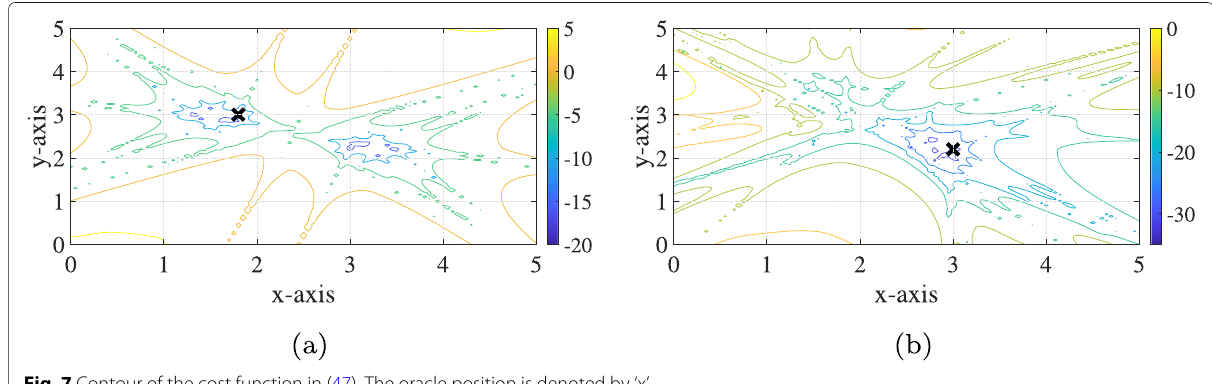
Fig. 7 Contour of the cost function in (47). The oracle position is denoted by ‘x’